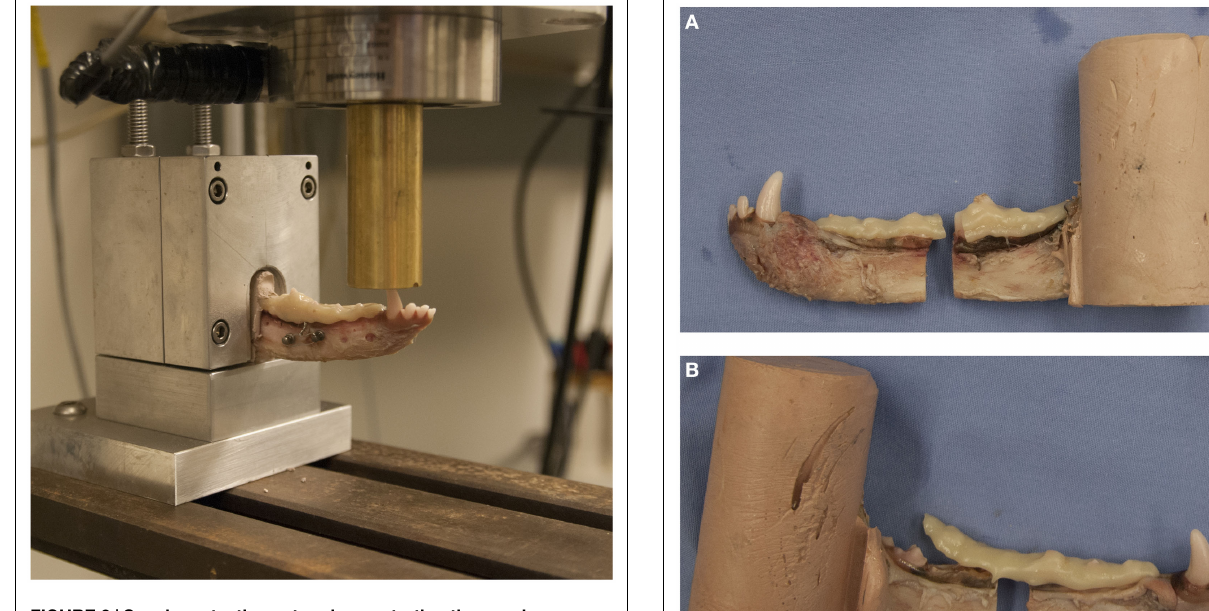
FIGURE 3 | Specimen testing setup demonstrating the specimen placed in a custom grip and point force cantilevered bending being applied to the canine tooth with a servohydraulic testing system .